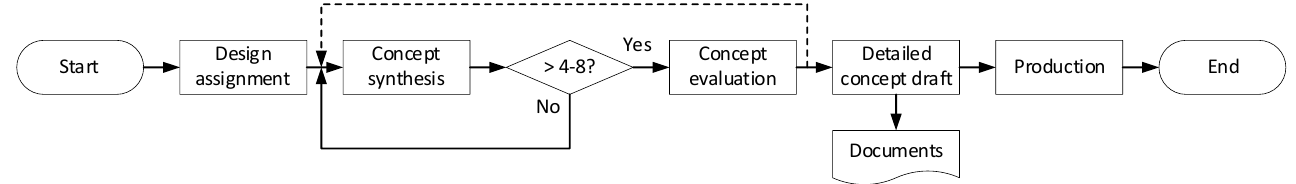
Figure 1. The flow chart of the design process (design loop shown in dashed line).